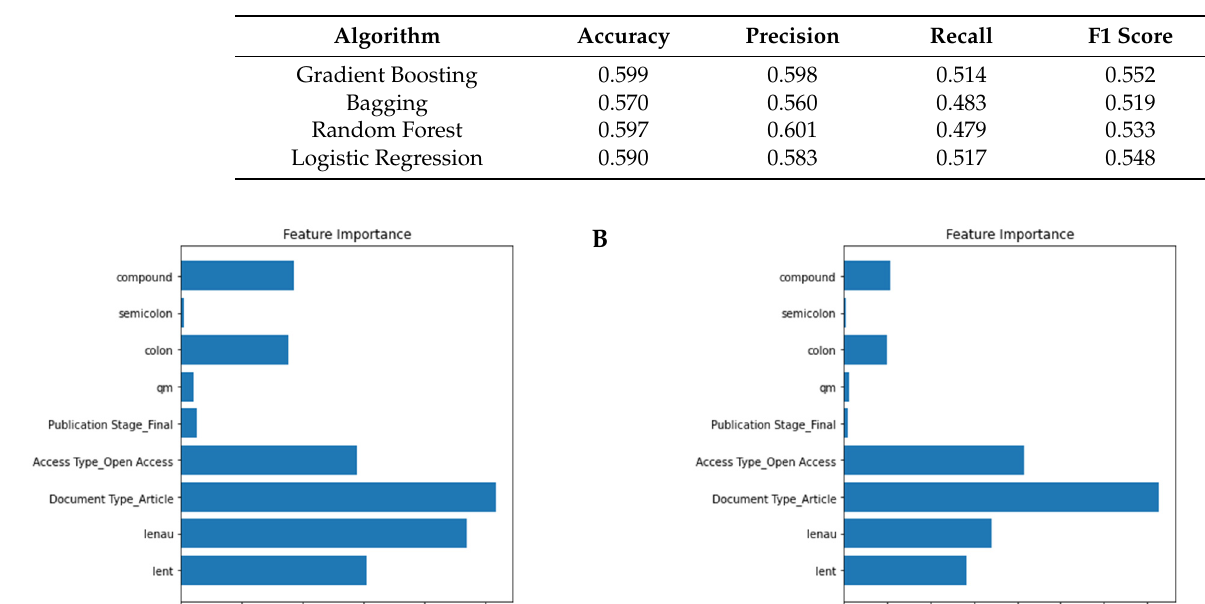
Figure 6. Overview of feature importance for ( A ) GradientBoost and ( B ) Random Forest classifier.